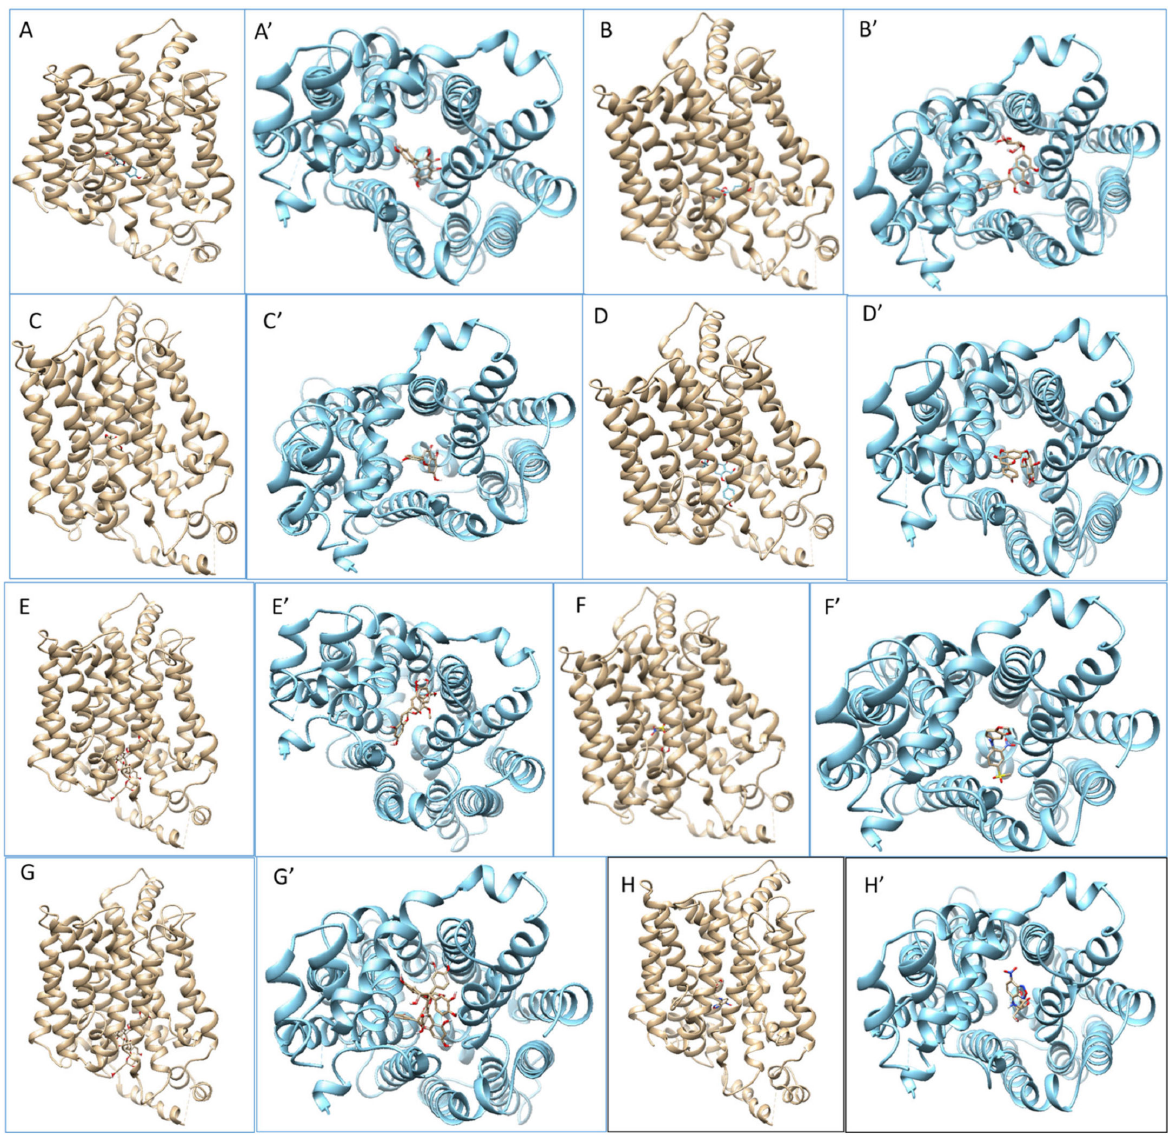
Figure 9. Graphical representation of the lowest energy conformations of GLUT5-ligand complexes obtained from molecular docking simulations: GLUT5-kaempferol ( A ); GLUT5-kaempferol-3- O -glycoside ( B ); GLUT5-apigenin ( C ); GLUT5-apigenin- 7- O -glucoside ( D ); GLUT5-epigallocatechin-3-gallate (ECGC) ( E ); GLUT5-MSNBA ( F ); GLUT5-procyanidin C1 ( G ); GLUT5- NBDF ( H ); vertical view of the GLUT5-ligand complex from the outside is presented with the brown structures of the transporter (picture marked with letter without ’) whereas the corresponding plan view is presented with blue structures of the transporter (picture marked with letter with